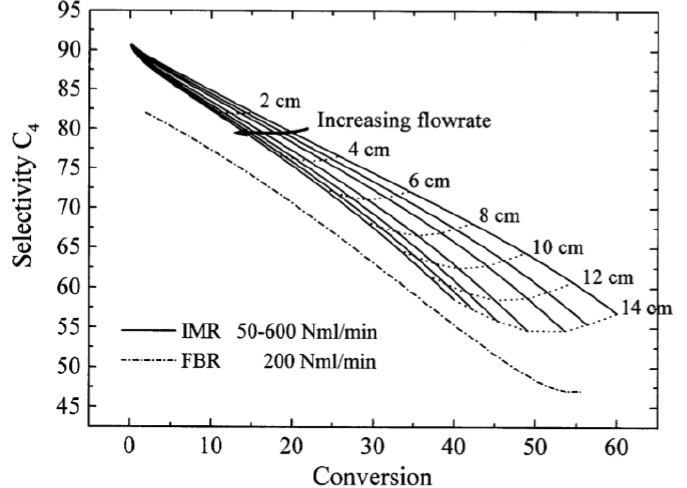
Figure 11. Selectivity–conversion plot for FBR (fixed bed reactor) and IMR (inert membrane reactor) of the oxidative dehydrogenation of butane over V/MgO catalyst. (Reprinted with permission from [55]. Copyright 1999